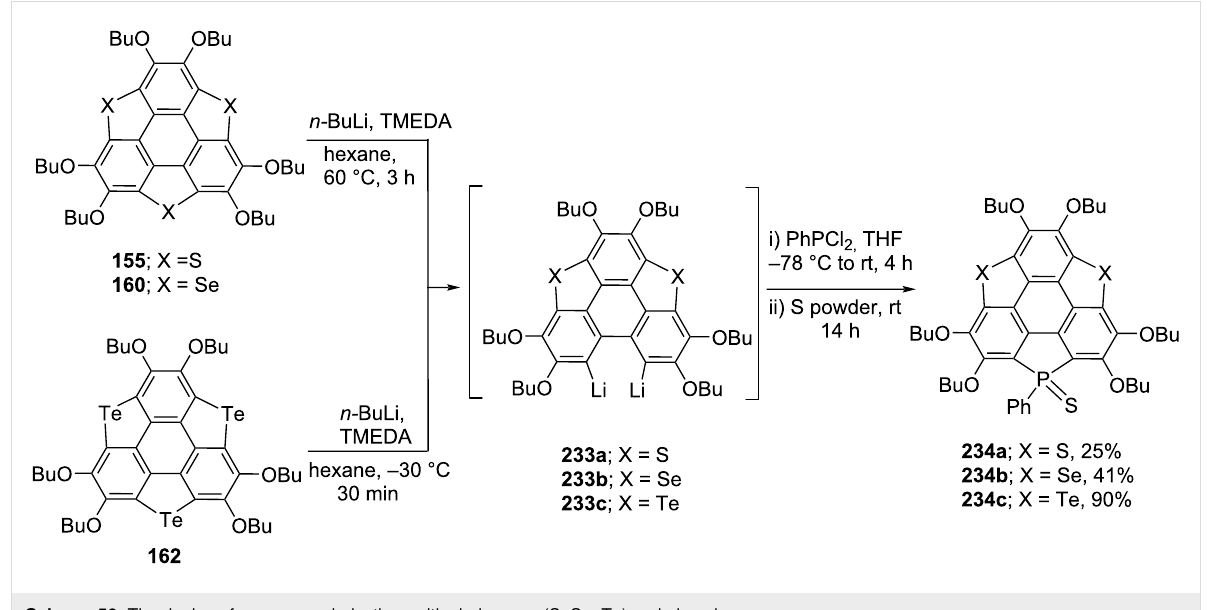
open only one of the rings to generate 233c which was